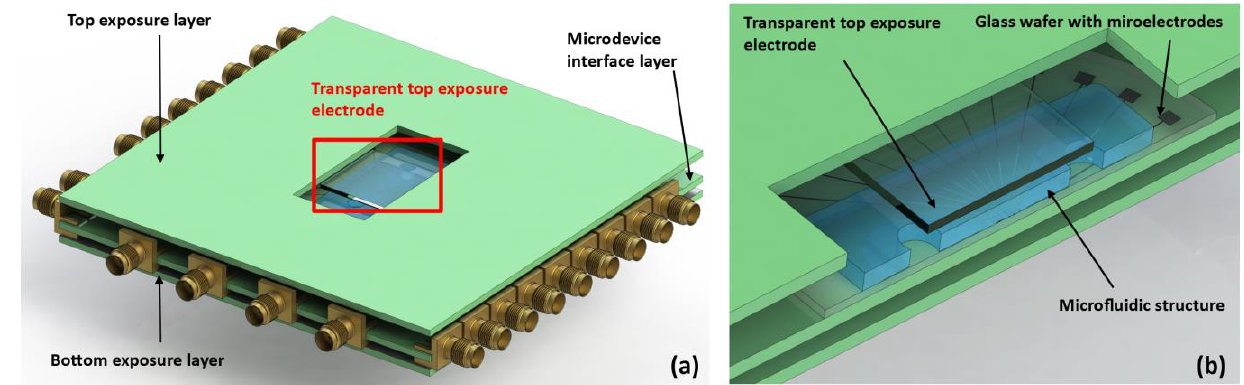
Figure 1. ( a ) A scaled 3D model of the device. ( b ) A cutaway view of the 3D model’s center showing the microelectrodes for BIS interrogation and the microfluidic channels.